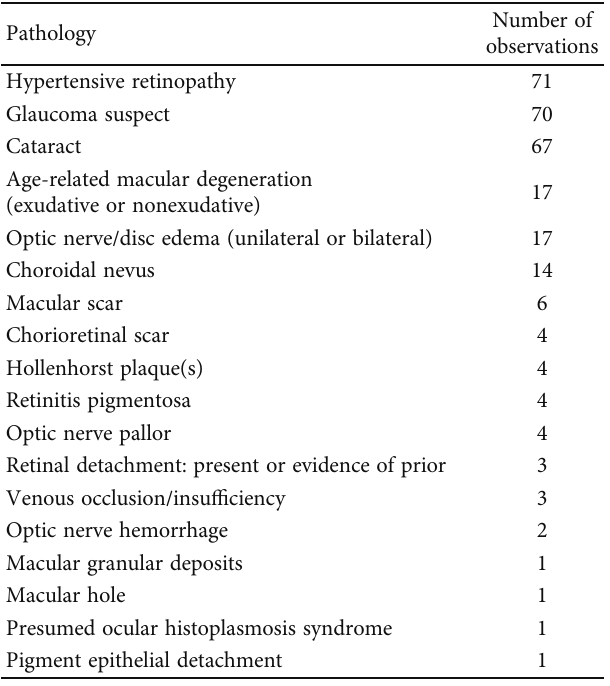
Table 5: Other pathologies observed in interpretable